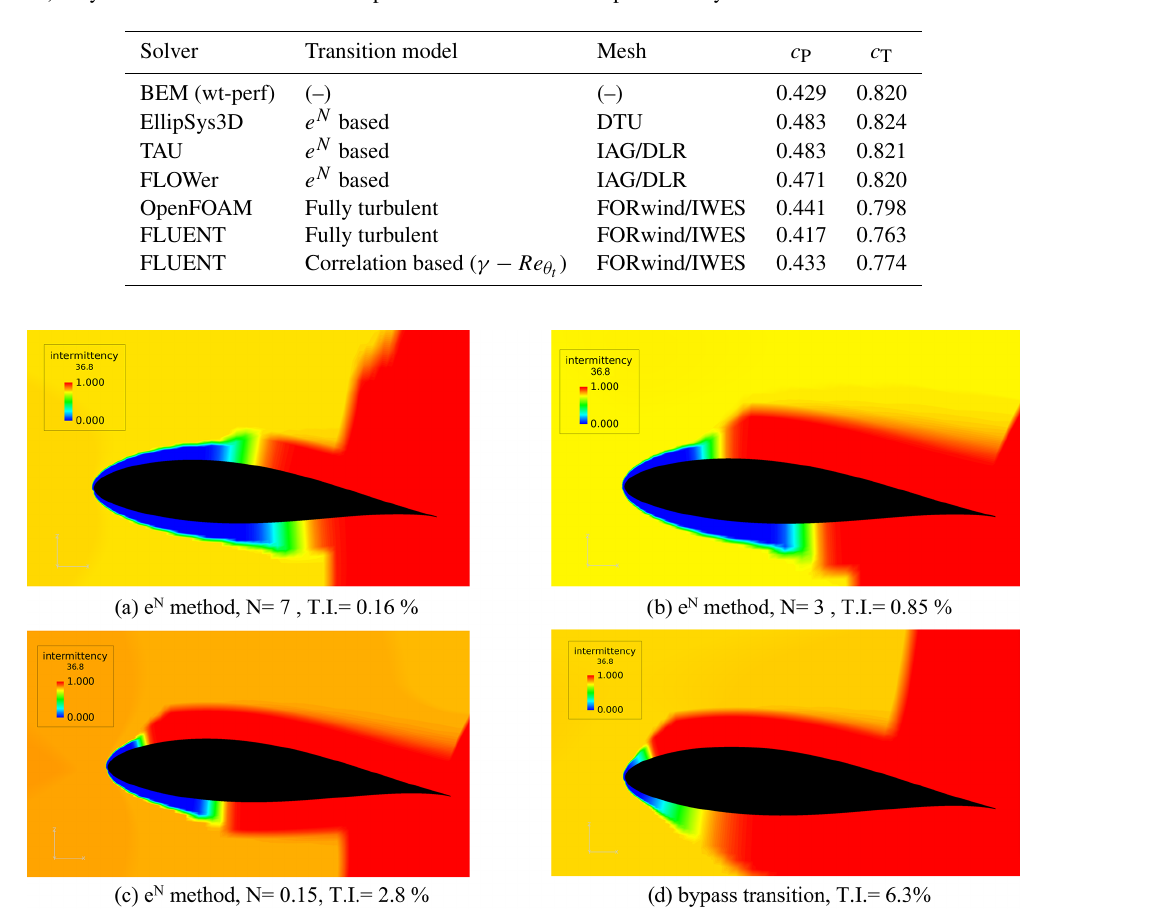
Table 3. Results for c T and c P from various computations. wt-perf is a BEM-code from NREL (Buhl, 2004) for aerodynamics (power, thrust, bending moment) only. These values have been incorporated for reasons of comparison only.